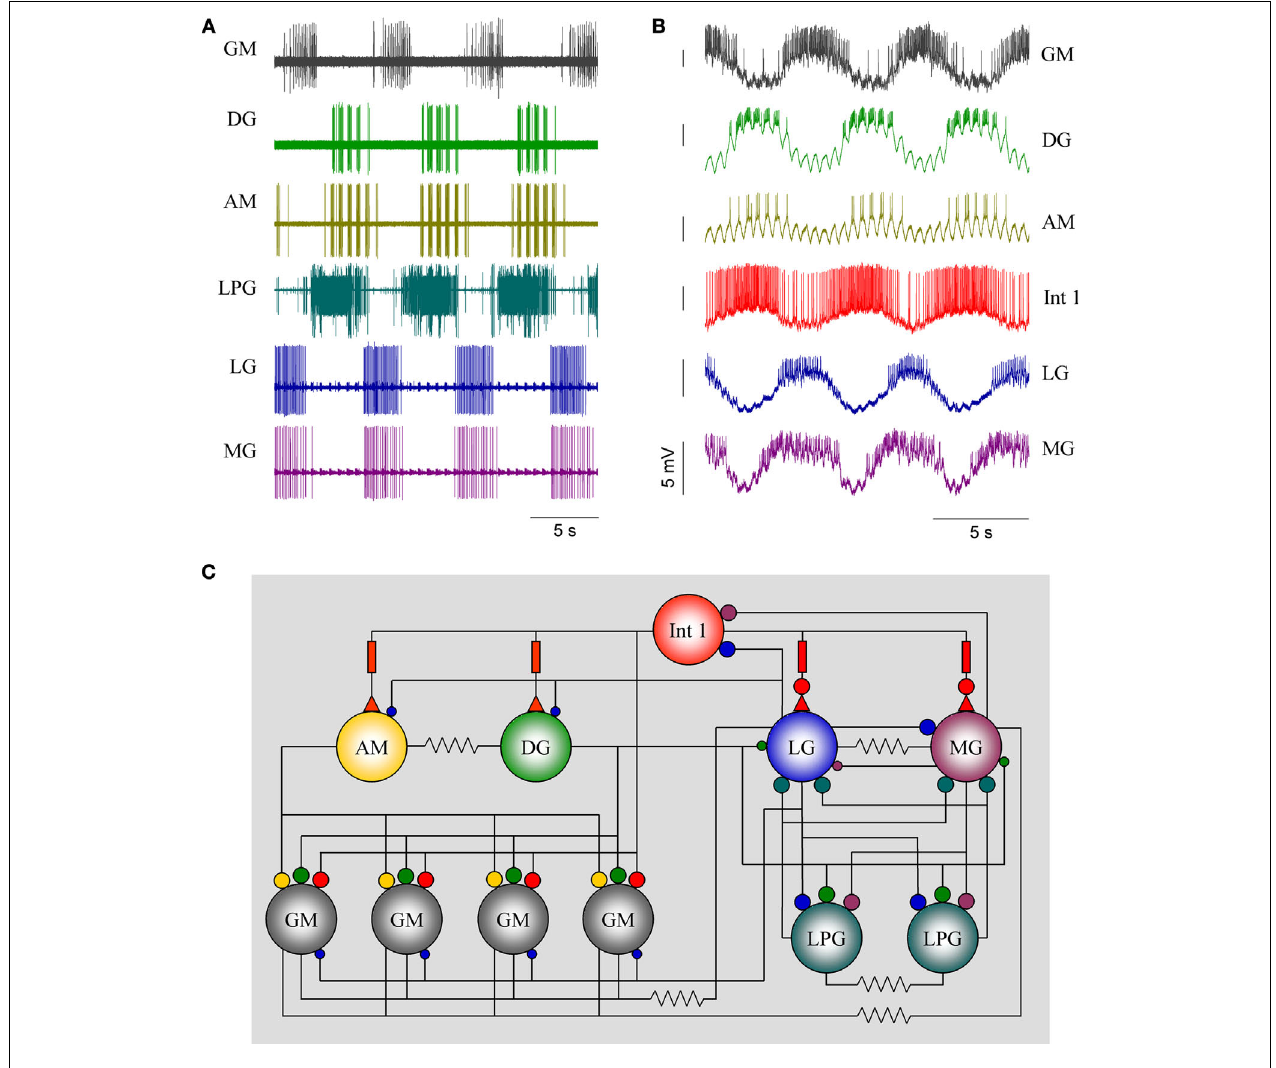
in relation to the motoneuron bursts. (C) The synaptic connectivity of the canonical gastric mill neural circuit. Large and small fi lled circles represent strong and weak inhibitory synapses respectively. Filled triangles represent excitatory synapses. Rectangles indicate delay mechanisms and resistors are electrical connections. Abbreviations of neurons are given in Table 1